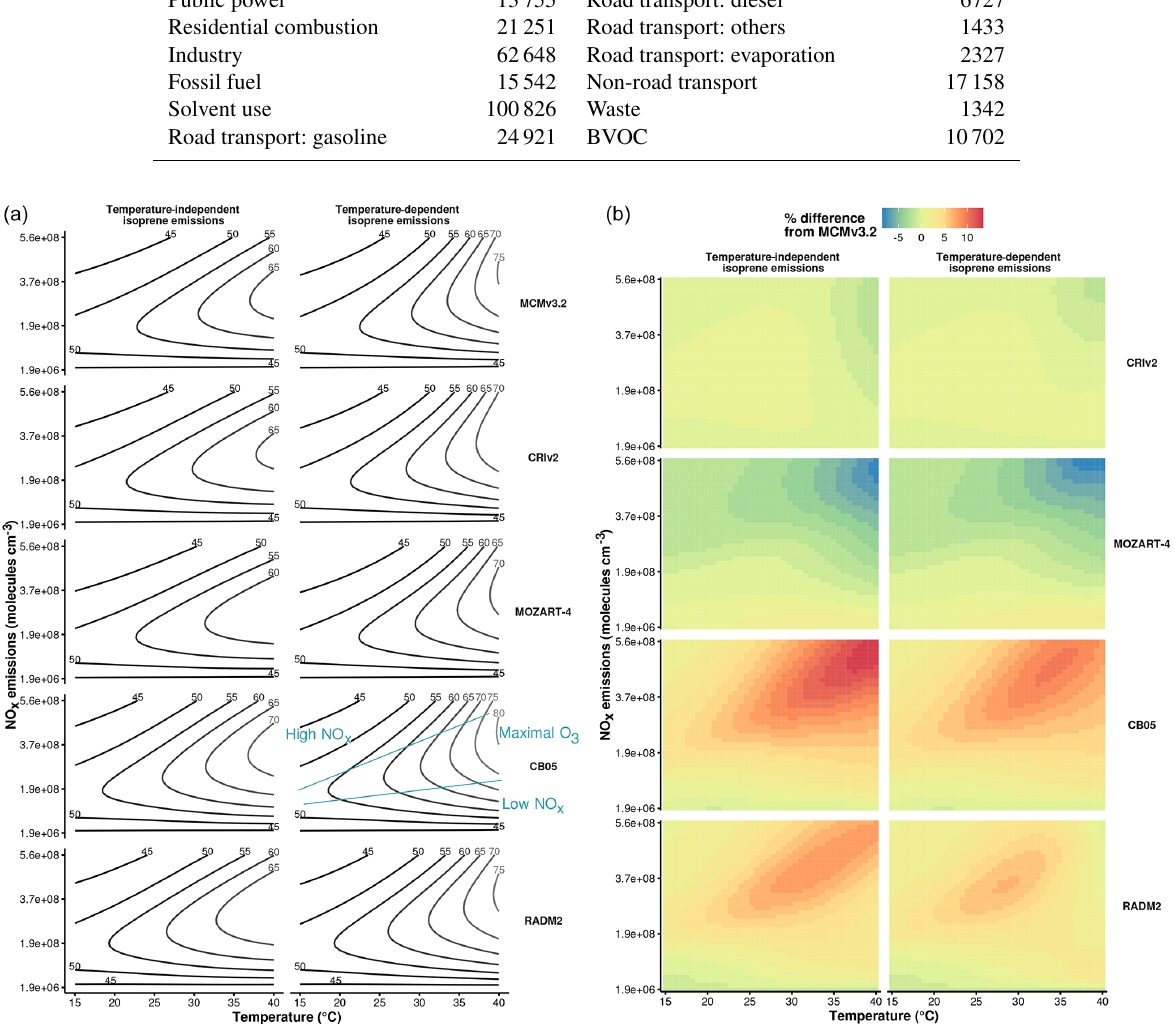
Figure 2. Ozone mixing ratios (ppbv) as a function of total NO x emissions and temperature for each chemical mechanism using a temperature-dependent and temperature-independent source of isoprene emissions. (a) Contours of peak ozone mixing ratios (ppbv) as a function of the total NO x emissions and temperature. The contours can be split into three separate regimes: high NO x , maximal O 3 and low NO x as indicated in the figure. (b) Percent difference in peak ozone from MCMv3.2 at each temperature and NO x